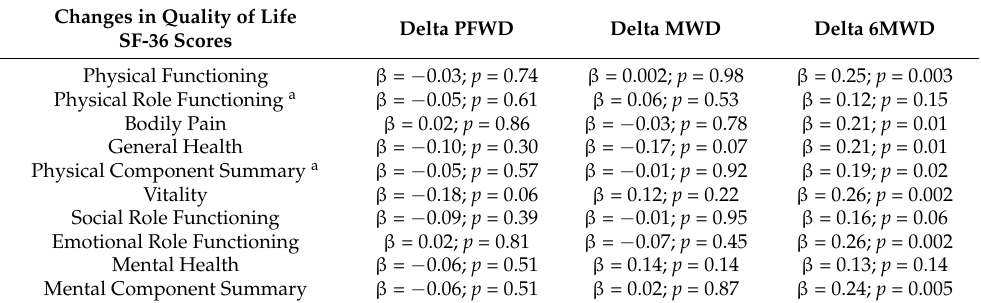
Table 4. Changes in treadmill performance and 6 min walking distance and their relationship to changes in health-related quality of life following supervised exercise training with multiple imputations.